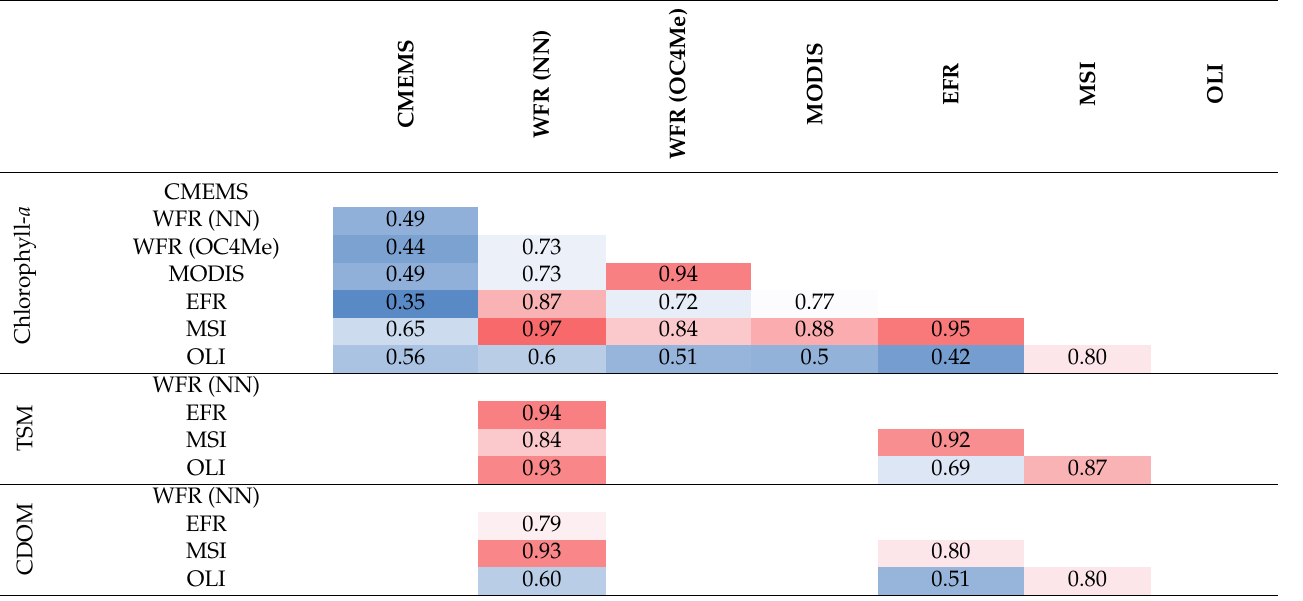
NB: Values are highlighted from largest (red) to smallest (blue). Significance level of p = 95% is